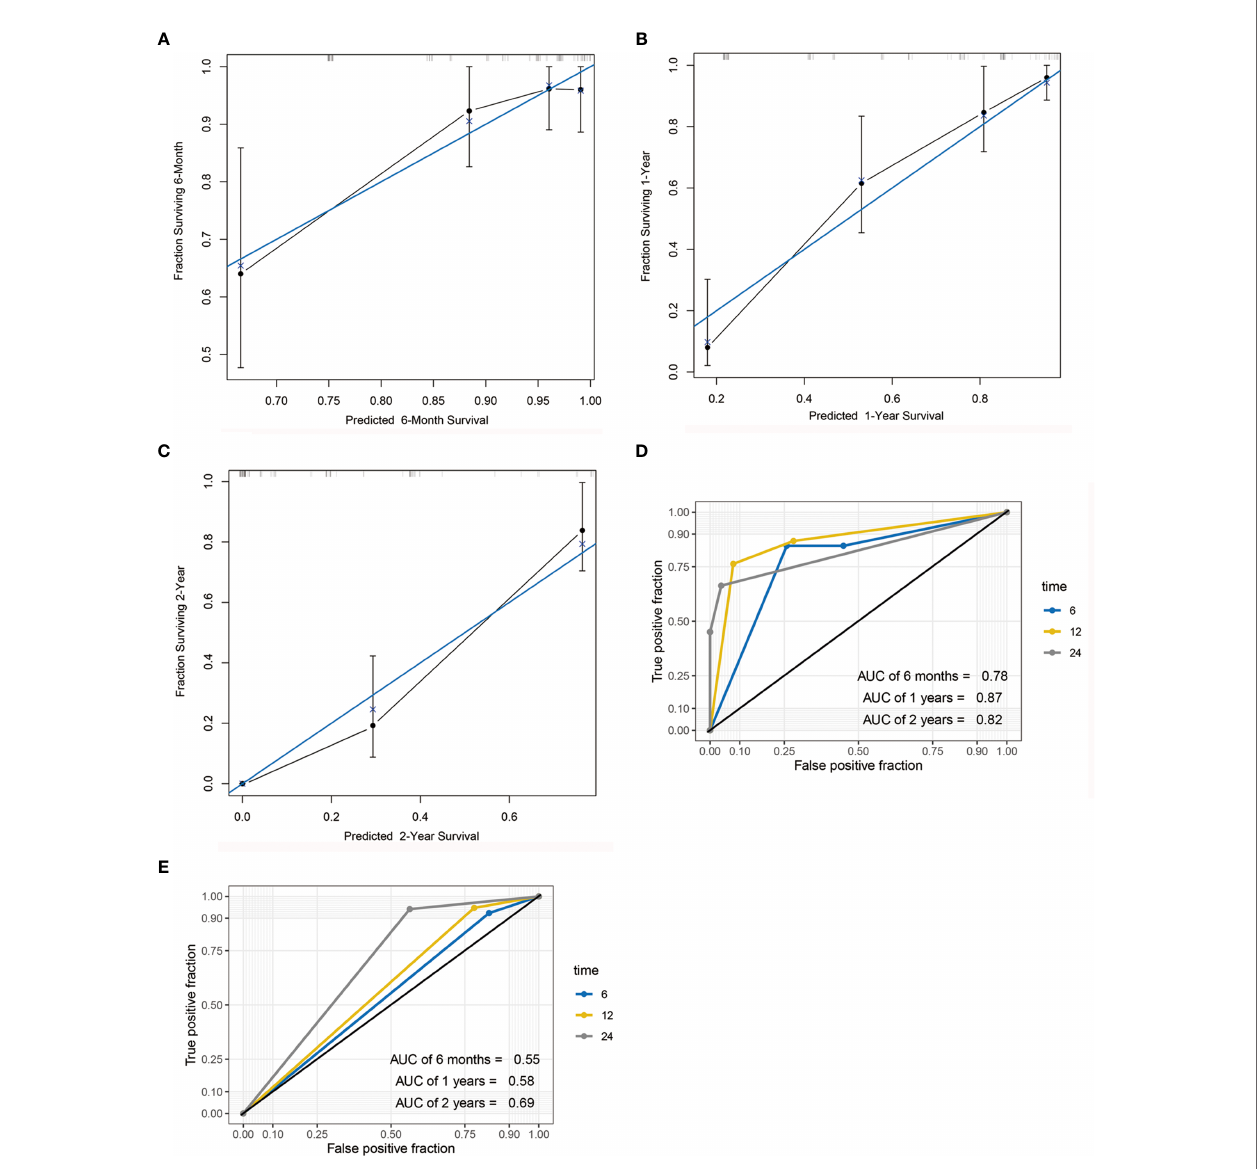
FIGURE 5 | Calibration curve and AUC graph. Calibration curve for predicting the survival rates of PDAC patients at 6 months (A) , 1 year (B) and 2 years (C) after surgery. Blue and black lines represent the ideal calibration curve model and the actual calibration curve, respectively. AUC graph of the nomogram (D) and TNM staging system (E) for the predicting postoperative 6-month, 1-year, and 2-year survival